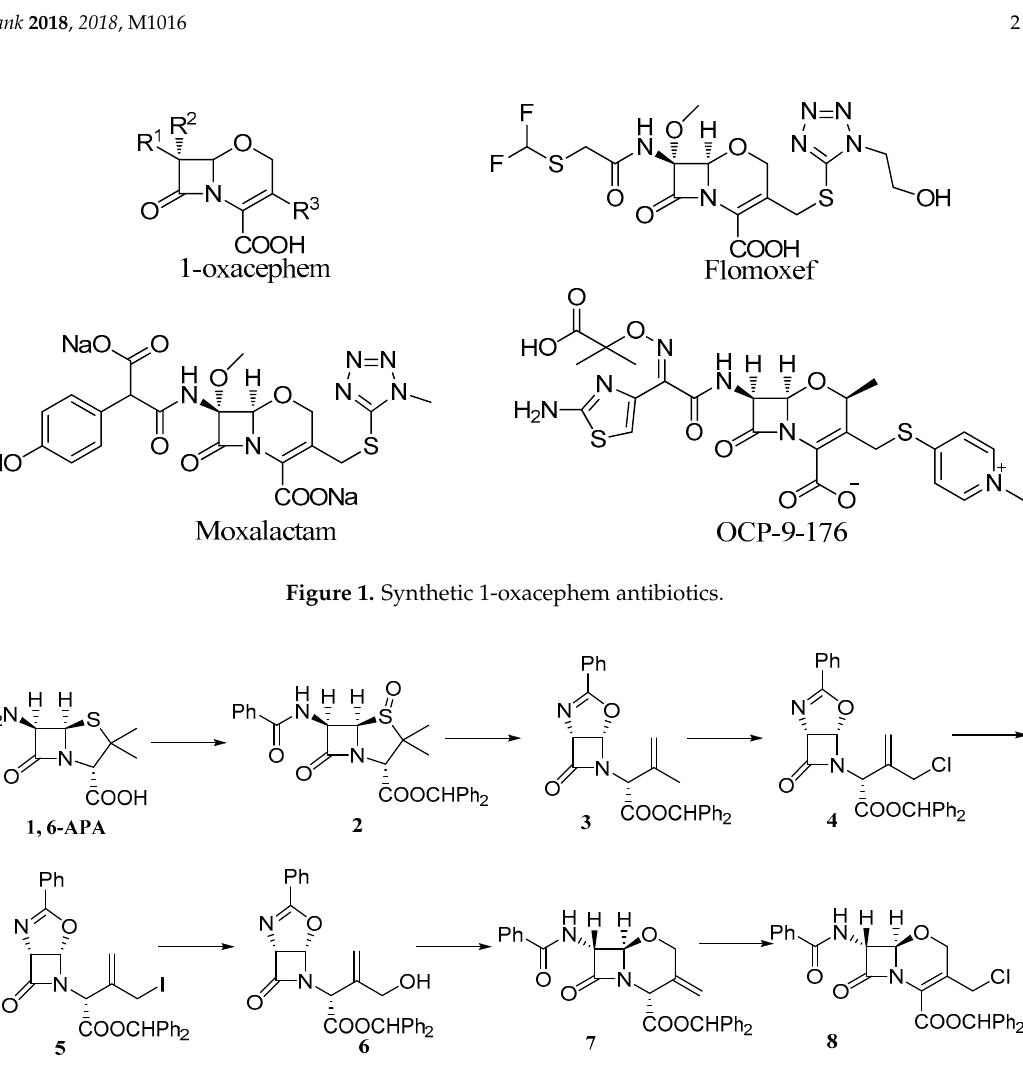
Figure 2. Feasible industrial synthesis of 1-oxacephem 8 .